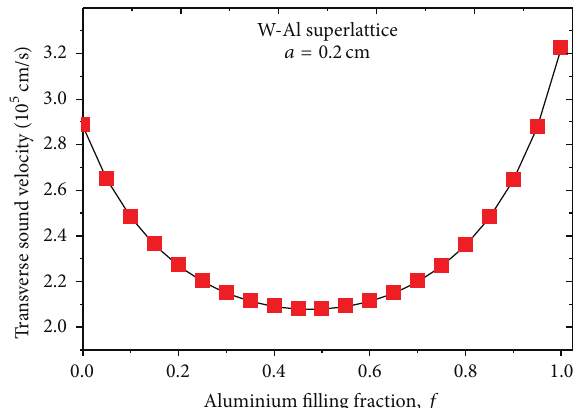
Figure 5: Effective sound velocity for transverse vibrational modes propagating along the growth direction of a W-Alsuperlattice.Here, solid line was obtained by using formula (33) and squares were obtained by using formula